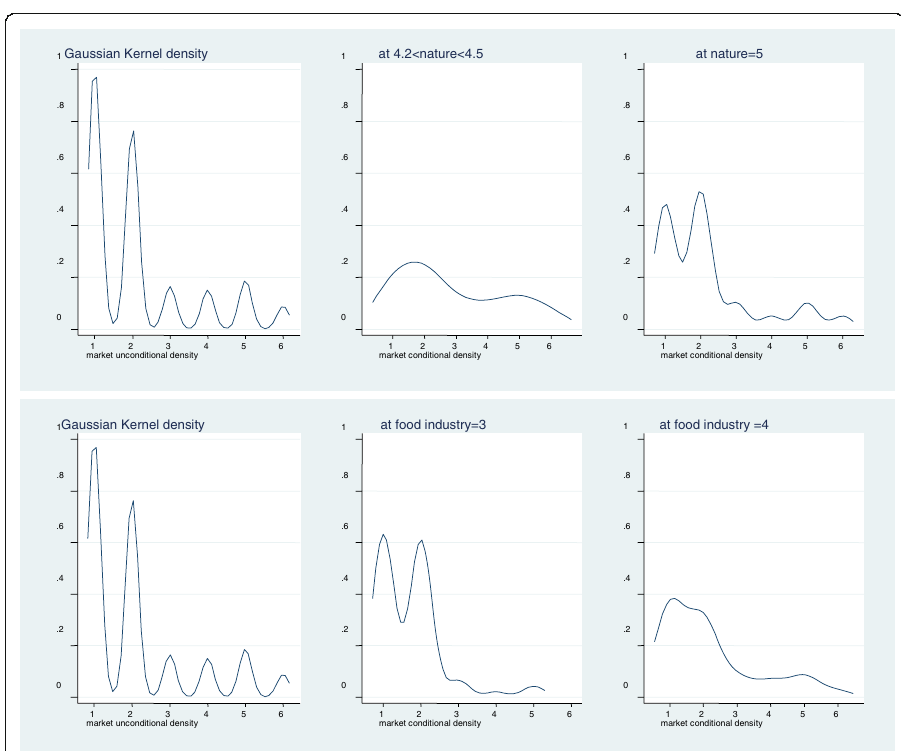
Fig. 3 Unconditional distribution of farmers ’ market and some examples of its conditional distributions at selected values of nature and of